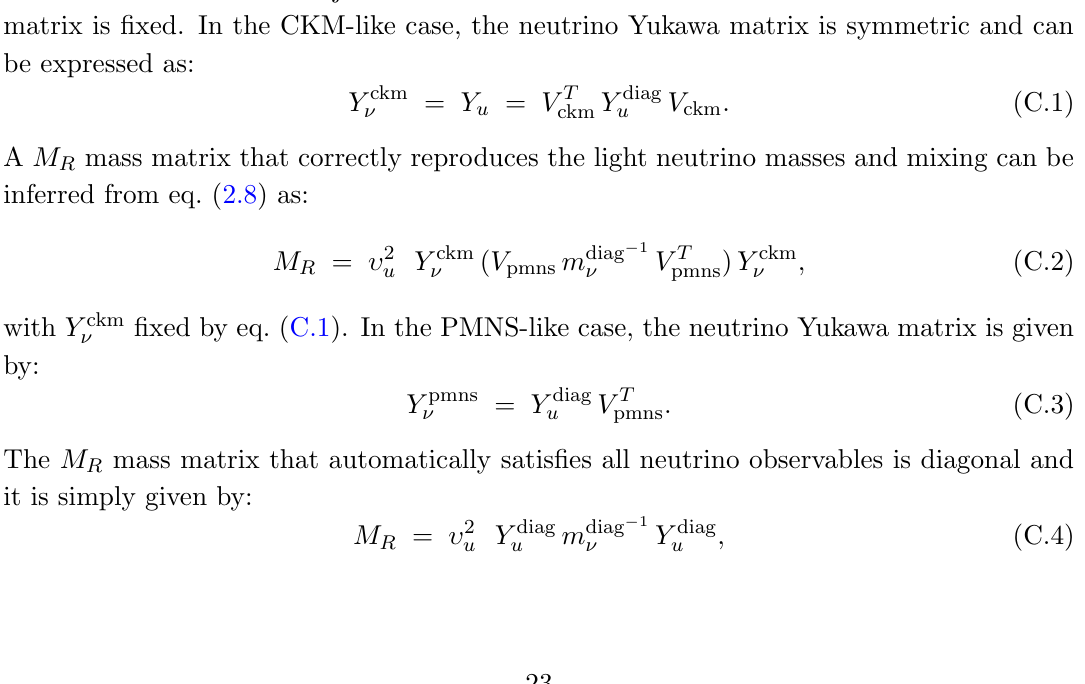
Figure 9 . Loop functions involved in a susy charginos (green/dark) and neutralinos